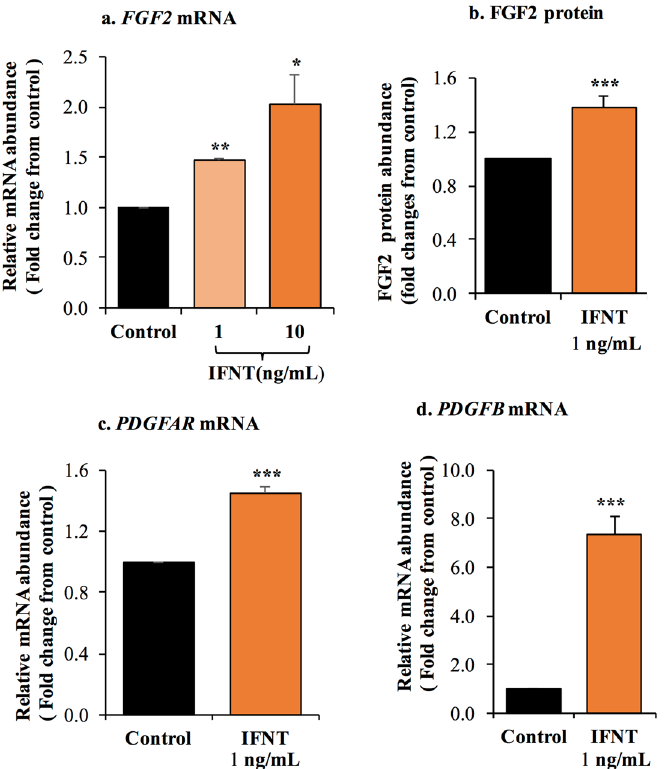
Figure 6. IFNT promotes proangiogenic factors in LGCs. LGCs were treated with either basal media (control) or roIFNT (1 and 10 ng/mL). ( a , b ) FGF2 mRNA and protein levels. ( c ) PDGFB and ( d ) PDGFAR mRNA expression. Asterisks indicate significant differences between roIFNT treatment and controls ( * P < 0.05, ** P < 0.01, *** P <